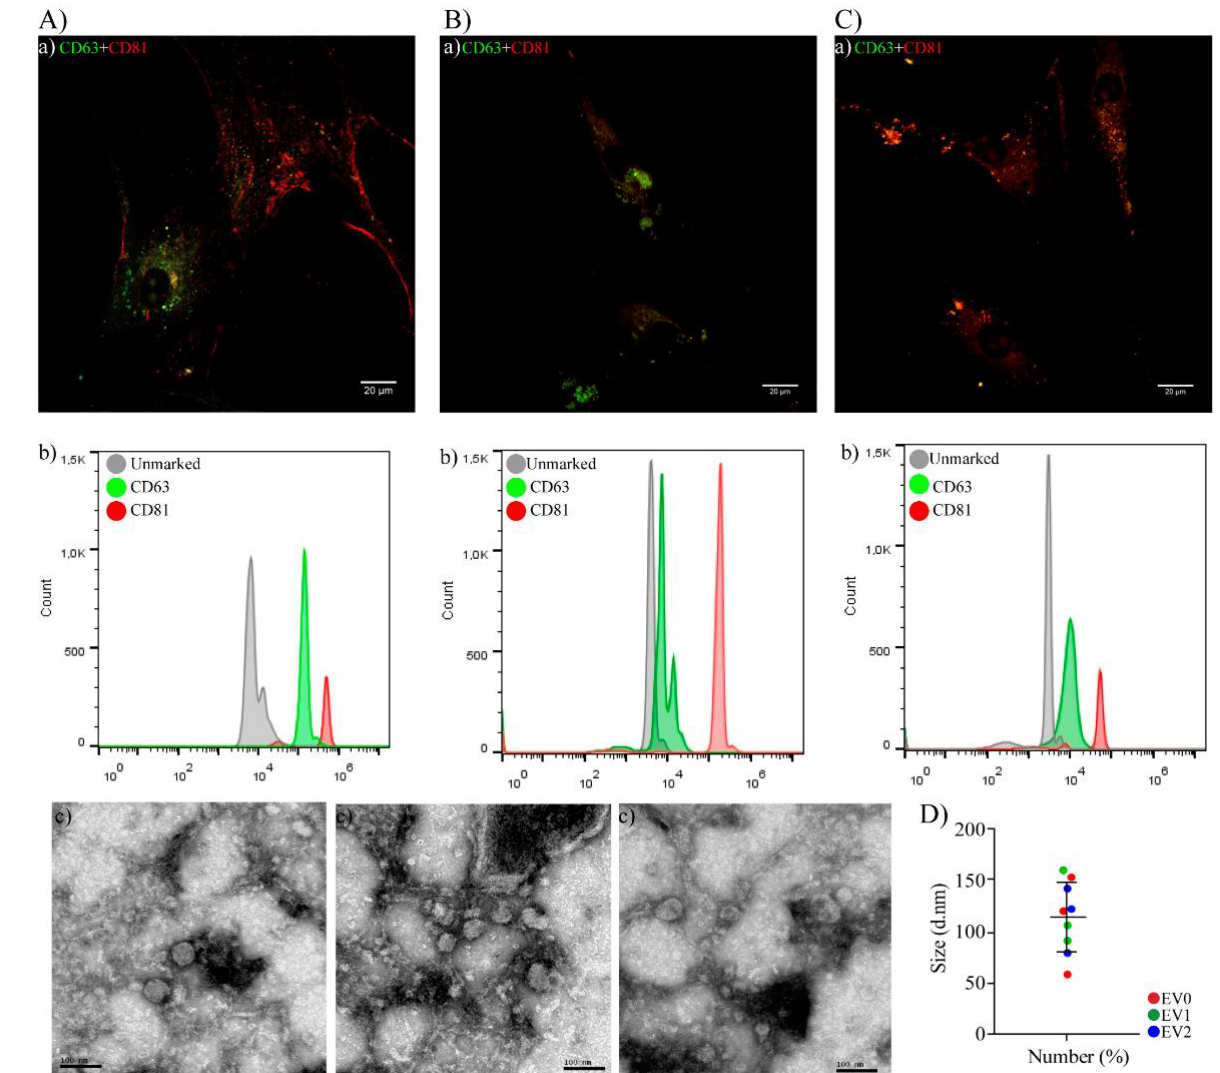
Figure 2. Characterization of EVs. The fluorescence signals of the following EV markers were observed inside the cells, EV0: ( Aa ), EV1: ( Ba ), and EV2: ( Ca ) Merged CD81 (red) and CD63 (green). Scale bars: 20 µm. Released EV characterization by flow cytometry with specific CD markers. The positive result was a peak fluorescence shift for CD63 (green) and CD81 (red). These results were compared with EV0 incubated only with beads (gray), EV0: ( Ab ), EV1: ( Bb ), and EV2: ( Cb ). Transmission electron microscopy (TEM) image by direct examination, demonstrating the diameter of hAT-MSC-derived EV0: ( Ac ), EV1: ( Bc ), and EV2 ( Cc ), by MET JEM 1200 EXll, magnification 200k, scale bar = 100 nm. ( D ) Average diameter (140 nm) evaluated by the Zetasizer instrument: EV0 (red), EV1 (green), and EV2 (blue).